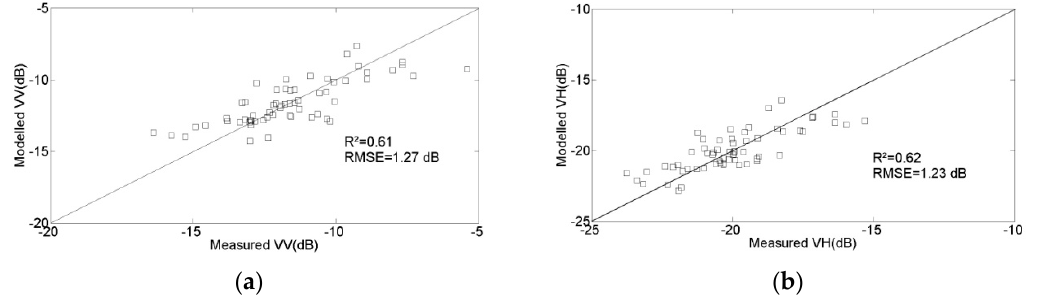
Figure 10. Empirical model validation: ( a ) VV polarization; ( b ) VH polarization. Table 3. Calibration parameters and statistical precision coefficients computed with the proposed empirical models, for the VV and VH polarizations, relative mean square error (RMSE) and correlation coefficient R 2 .